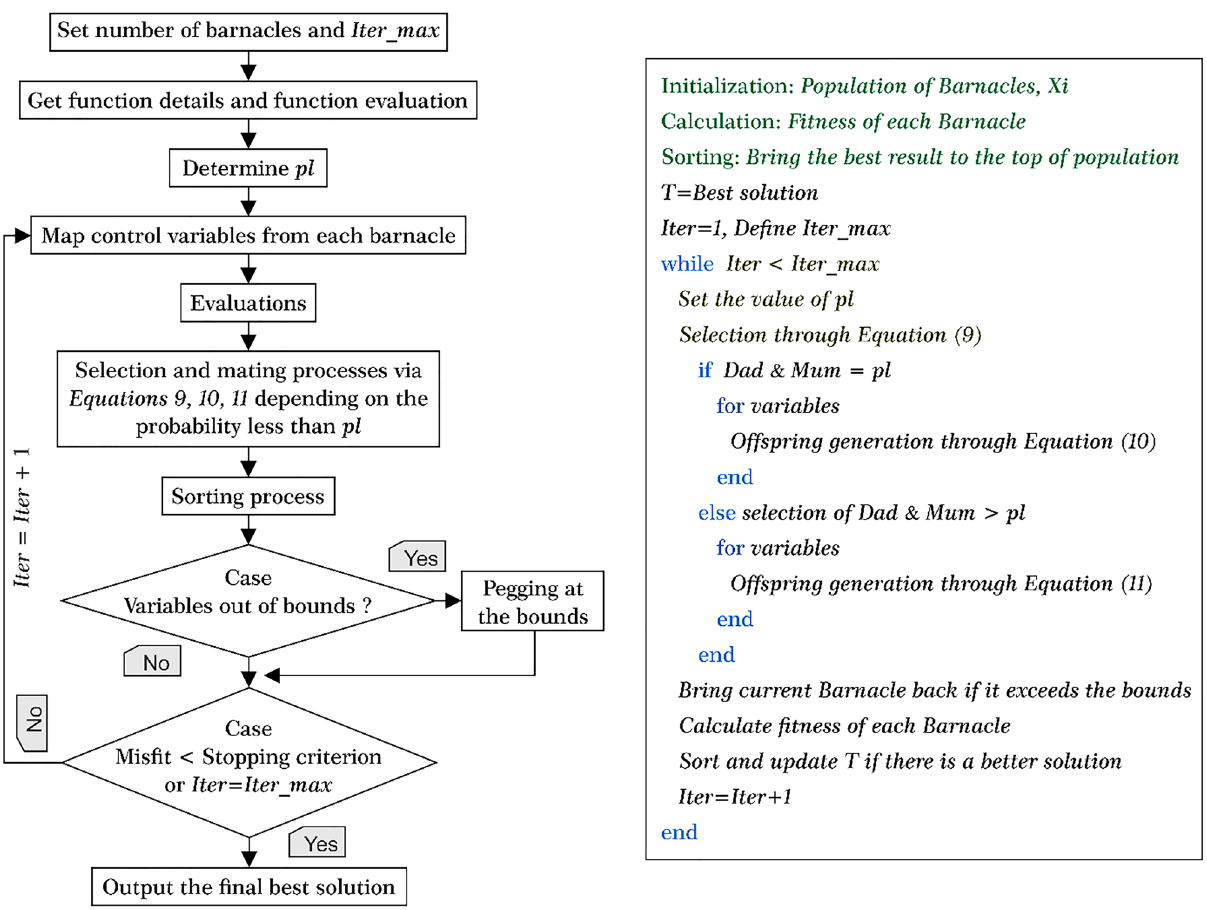
Figure 2. Workflow and pseudocode of the BMO (modified from the original study 65